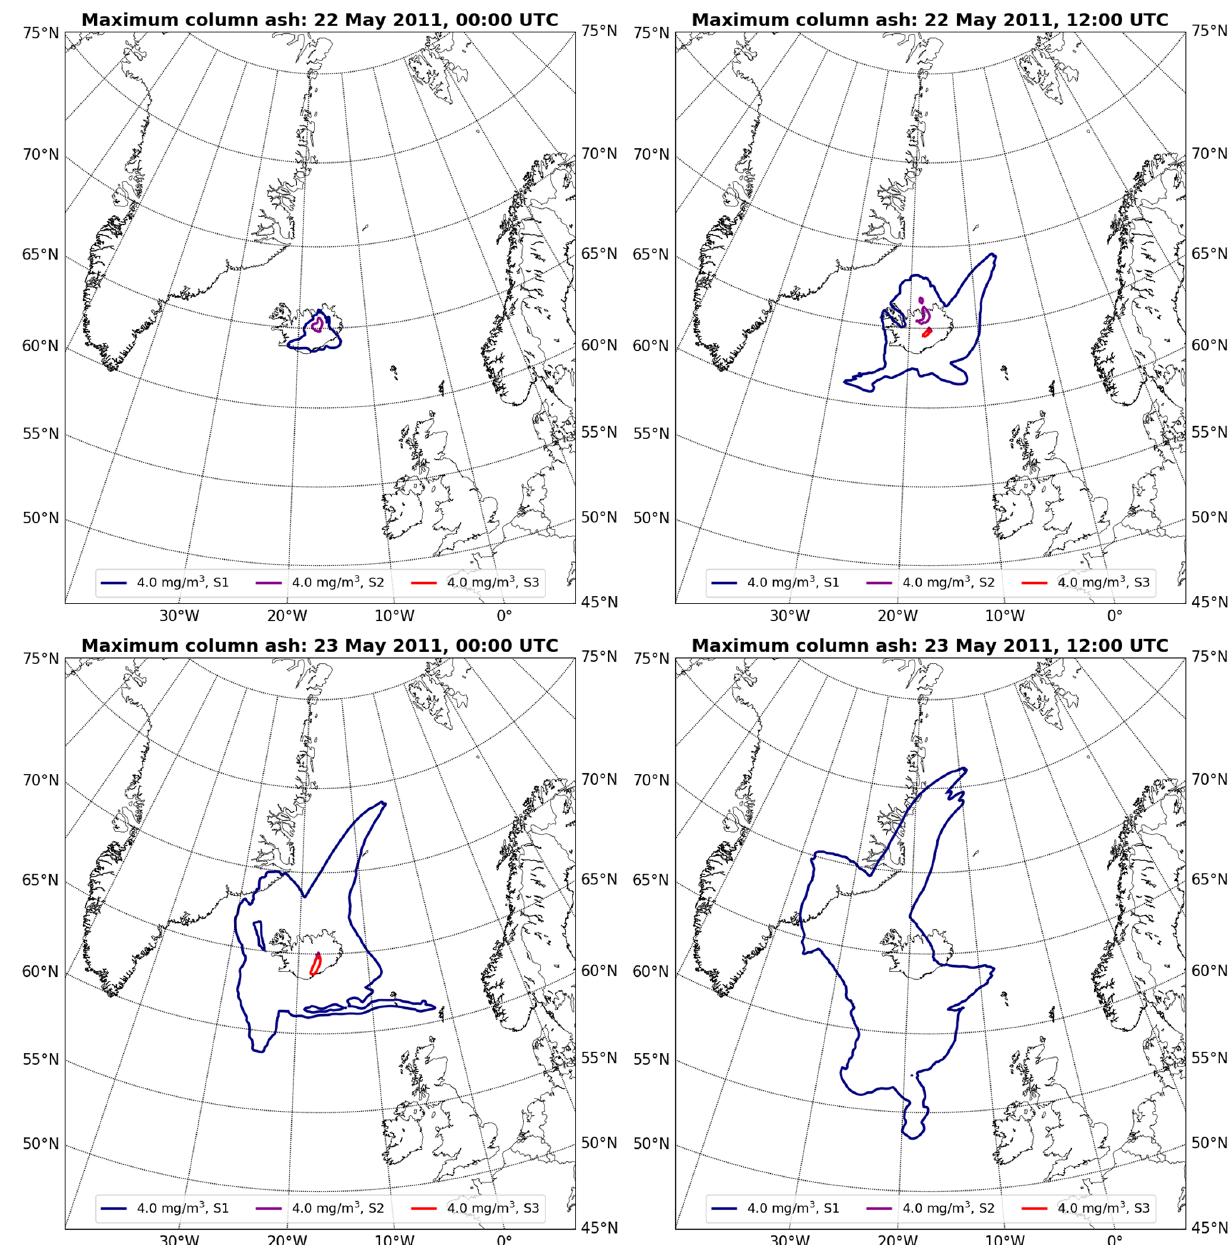
Figure 6. Maximum sub-column concentrations of total ash indicated via the 4mg/m 3 isoline for each grid cell predicted for the first 2d (22 and 23 May 2011, 00:00 and 12:00UTC) after the eruption start for the three emission scenarios simulated with